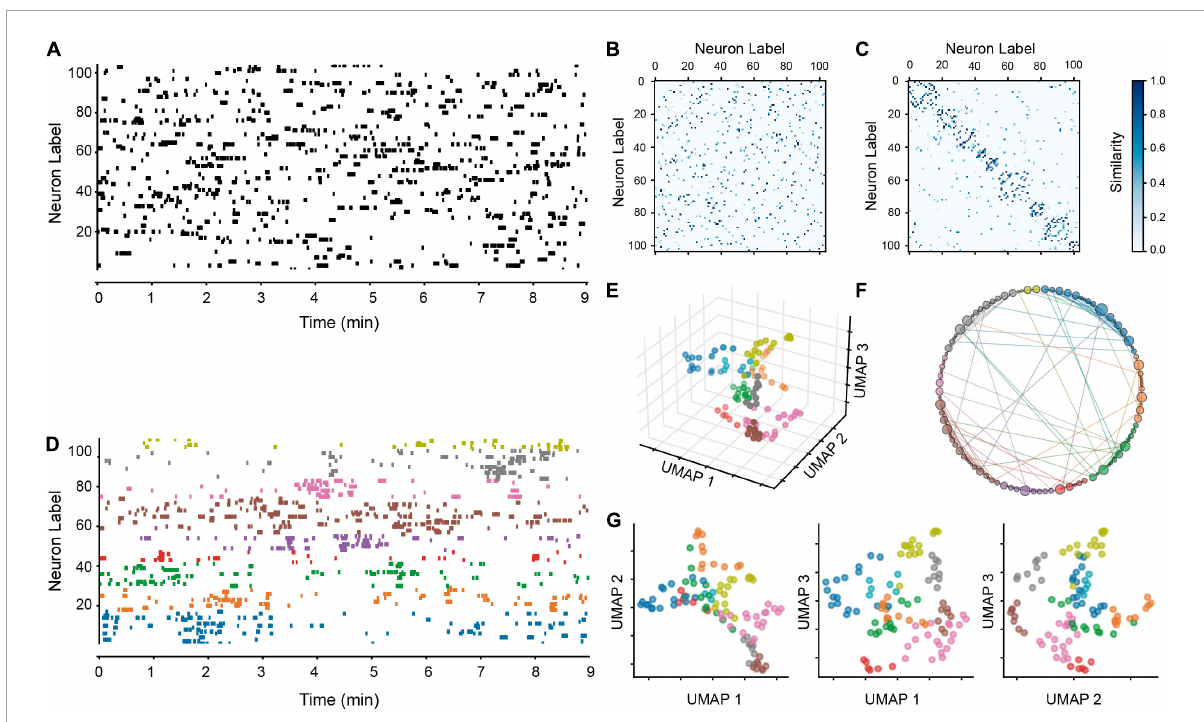
FIGURE3 Identification of neuronal ensembles from calcium imaging experiments. (A) Raster plot. Each row corresponds to the activity of a neuron during an experiment. Black periods indicate moments of inferred electrical neuronal activity (events) where neurons have a high probability of firing action potentials. Dozens of neurons can be monitored simultaneously for several minutes, allowing the analysis of phenomena that can only be recorded in neuronal populations. (B) Adjacency matrix of neuronal activity ( V A ) determined with UMAP, neurons that are close together in the high-dimensional space display a functional connection (Fröhlich, 2016). (C) Adjacency matrix sorted after identifying neuronal communities: neurons show a significant number of connections within the same ensemble and significantly fewer connections with neurons from other ensembles. (D) Sorted raster plot after reordering the neurons according to their communities. These communities exhibit the properties attributed to neuronal ensembles (Buzsáki, 2010). Notice clusters of neurons (colored) alternating their activity following temporal sequences. (E) Low-dimension UMAP projection of active neuronal matrices identified in the experiment. Colors denote the same ensembles present in panel (D) . Neuronal ensembles occupy different positions in space after dimensional reduction. (F) Circular visualization of neuronal ensembles and their functional connections is obtained from the adjacency matrix B and colored as in panel (D) . Neurons present most of their connections with neurons of their own ensemble, and links among ensembles may represent the connectivity that enables the alternating activity during temporal sequences: how an ensemble is turned off when another is turned on. (G) Bidimensional projections in low dimension UMAP space to better appreciate communities’ separation from different